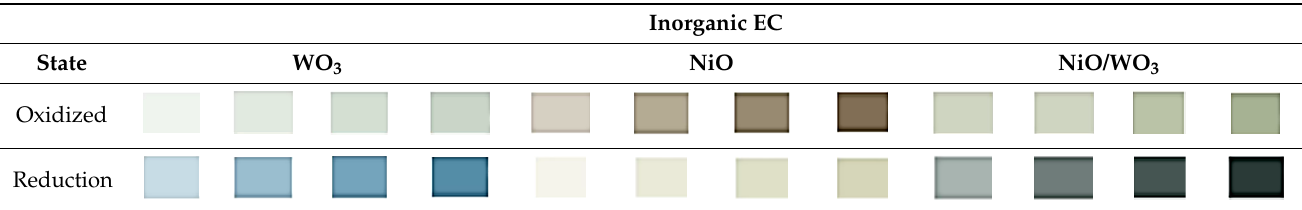
Table 5. Color variation in WO 3 , NiO and WO 3 /NiO electrochromic films (colored and bleached states). Inorganic EC